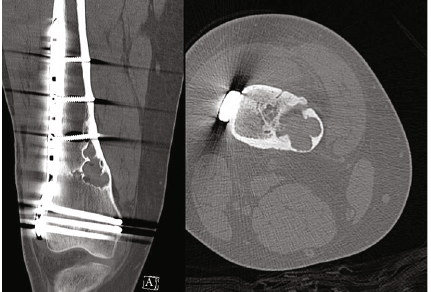
Figure 4: CT obtained 16 months postoperatively showing an anterior cortical defect approximately 7cm proximal to the distal femur.